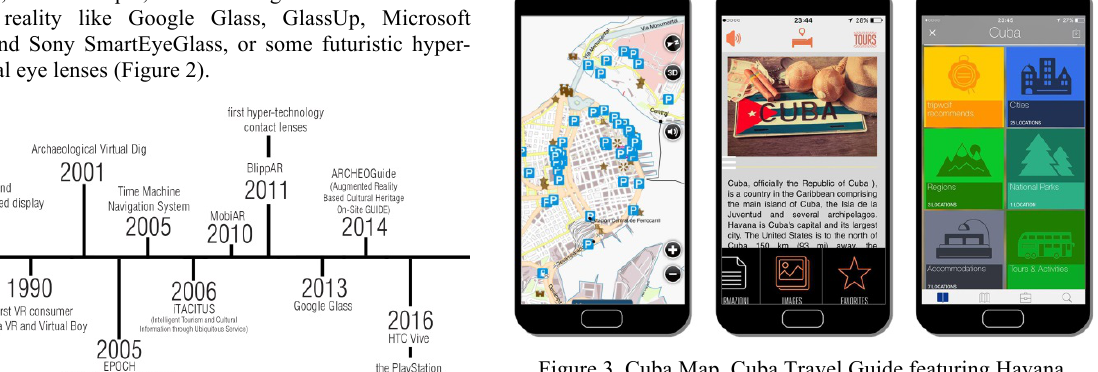
Figure 3. Cuba Map, Cuba Travel Guide featuring Havana, Varadero and more! and Cuba Tourism